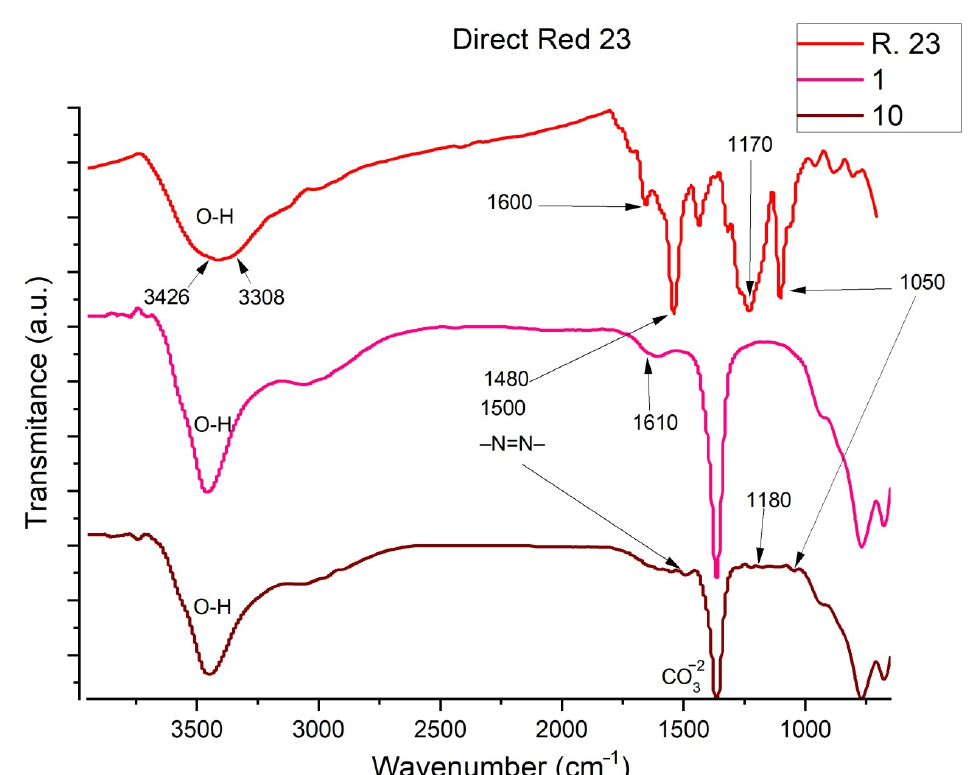
Figure 15. FTIR of Direct Red 23, Sample 1 and Sample